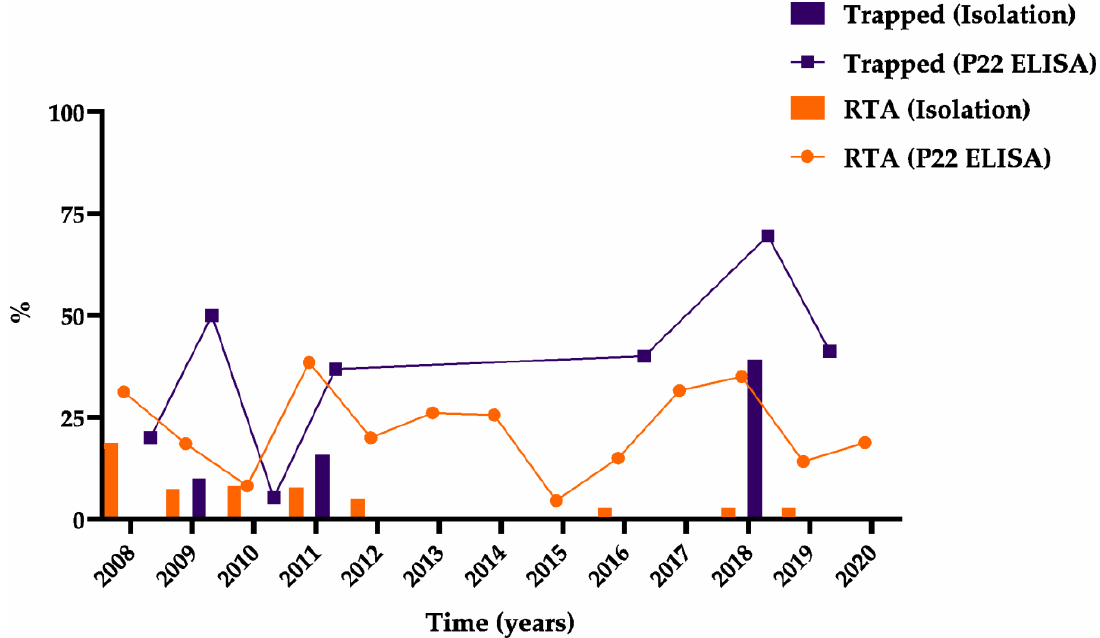
Figure 4. Prevalence of tuberculosis among trapped badgers (purple color) or badgers killed in road traffic accidents (RTA) (orange color) by year. The isolates are represented with columns for each of the two animal groups, and the lines represent seroprevalence. Circles refer to results based on P22 ELISA for the RTA, and the squares refer to results based on P22 ELISA for trapped animals. Note that trapping was not carried out in 2012–2015, 2017, or 2020, so all badgers studied in those years were RTA.